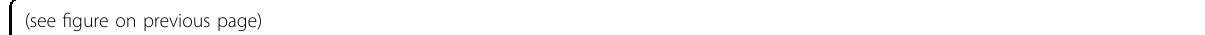
Fig. 2 Regulation of AXL and β -catenin expression and role in drug resistance of CLL B-cells in presence of BMSCs. A , B Expression of β -catenin and P-ERK-42/44 in nuclear and cytosolic fractions of CLL B-cells co-cultured with or without BMSCs. Nuclear and cytosolic fractions from CLL B-cells were analyzed to detect β -catenin, P- β -catenin (Ser33/37/Thr41), P-ERK-42/44, ERK-42/44, and AXL. LaminA and actin were used as loading controls. C Increased P-GSK3 β in CLL B-cells co-cultured with BMSCs. CLL B-cell lysates were analyzed for the P-GSK3 β (Ser9), GSK3 β , AXL, β -catenin, P- ERK-42/44, and ERK-42/44. Actin was used as a loading control. D Inhibition of ERK-42/44 signaling reduces expression of both AXL and β -catenin in CLL B-cells. PD98059 (70 μ M) treated co-cultured CLL B-cell lysates were analyzed for the levels of AXL, β -catenin, P-ERK-42/44, and ERK-42/44. Actin was used as a loading control. E Increased c-Jun activity in CLL B-cells co-cultured with BMSCs. CLL B-cell lysates were analyzed for the P-c-Jun (S73) and total c-Jun expression levels 48 h after co-culture. Actin was used as a loading control. F P-c-Jun expression in lymphoma B-cells. Lymphoma B- cell lysates from Mino or Raji or SU-DHL4 cells co-cultured with or without primary BMSCs were analyzed for the P-c-Jun (S73) and total c-Jun expression levels. G Inhibition of c-Jun activity reduces expression of both AXL and β -catenin in CLL B-cells. SP600125 (15 μ M) treated CLL B-cell lysates from co-culture were analyzed for the levels of AXL, β -catenin, P-c-Jun(S73), c-Jun. Actin was used as a loading control. H AXL regulates β -catenin expression in Mino cells. Mino cells were co-cultured with BMSCs after transduced with control (empty) lentivirus or with virus expressing guide RNAs targeting AXL. Actin was used as a loading control. I – L Inhibition of ERK-42/44 activity increases sensitivity towards drug-induced killing of CLL B-cells in co-culture. CLL B-cells treated with the following drugs; fl udarabine [FU] (3.5 μ M) ( I ) or chlorambucil [Chl] (15 μ M) ( J ) or venetoclax [Ven] (2.5 nM) ( K ) or TP-0903 [TP] (0.15 μ M) ( L ) alone or in combination with PD98059 [PD] (70 μ M) for 48 h in co-culture with BMSCs and induction of cell death was assessed using fl ow cytometry after staining with annexin/ propidium iodide. Each drug treatment was done with CLL B-cells from two patients in triplicate. Results are presented as mean values with SD. CLL patients (P1, P4, P5, P14, P19, P20, P30, P31, P52, P53, P62), normal BMSC (N1, N5 – N8, N16, N17, N20, N23, N32, N33, N37, N49), and CLL BMSCs (P1, P2, P5 – P7, P9, P11, P12) are indicated by arbitrary numbers. M AXL, β -catenin, P-ERK-42/44, and P-c-Jun expression levels in B-cells from CLL patients. Expression levels were determined on puri fi ed leukemic B-cell lysates obtained from CLL patients ( n = 5) before treatment and while being treated or after treatment. Actin was used as a loading control. ‘ CIT ’ indicates chemo-immunotherapy. CLL patients (P1 – P5) are indicated by arbitrary numbers. ‘ N ’ represents a normal (healthy) control and ‘ P ’ represents a given patient. N Simpli fi ed model of CLL B-cell and BMSC interaction. BMSC induces expression of both AXL and β -catenin in CLL B-cells when co- cultured with BMSCs (blue arrow). Further increase in AXL and β -catenin expression is observed when drugs are added to the CLL B-cell and BMSC co-culture (double red arrows). Elevated level of P-ERK-42/44 in CLL B-cells in the presence of BMSCs, enhances AXL expression and β -catenin accumulation through GSK3 β inactivation. Activation of c-Jun in presence of BMSCs also increases AXL expression level and may modulate the increase in β -catenin level (red broken arrow) in CLL B-cells. AXL also may regulate the β -catenin expression (red broken arrow) in CLL